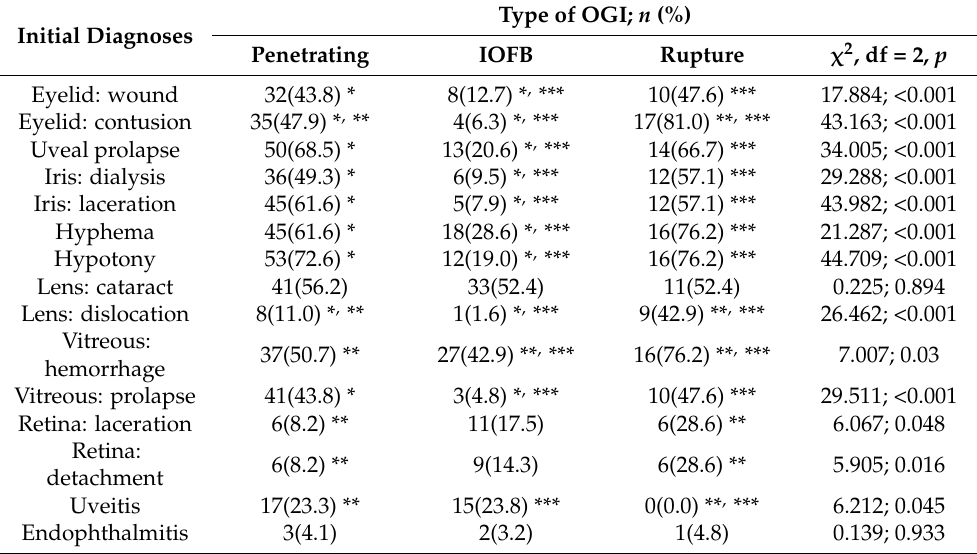
Table 3. Distribution of initial diagnoses by type of open globe